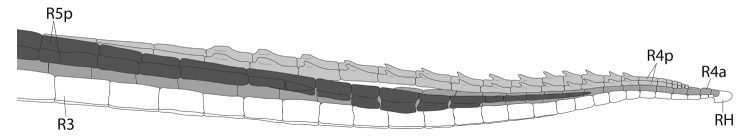
Schematic diagram of the distal tip of the gonopodium in Poeciliopsis
jackschultzi (TCWC 20082.01, paratype, male, 19.0 mm SL). Abbreviations: R3, ray 3; R4a, ray 4 anterior branch (intermediate grey); R4p, ray 4 posterior branch (light grey); R5p, ray 5 posterior branch (dark grey).